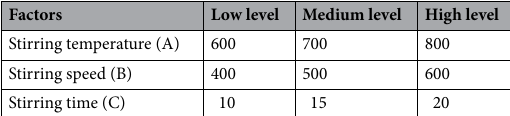
Table 3. Levels of factors in the design of experiment.